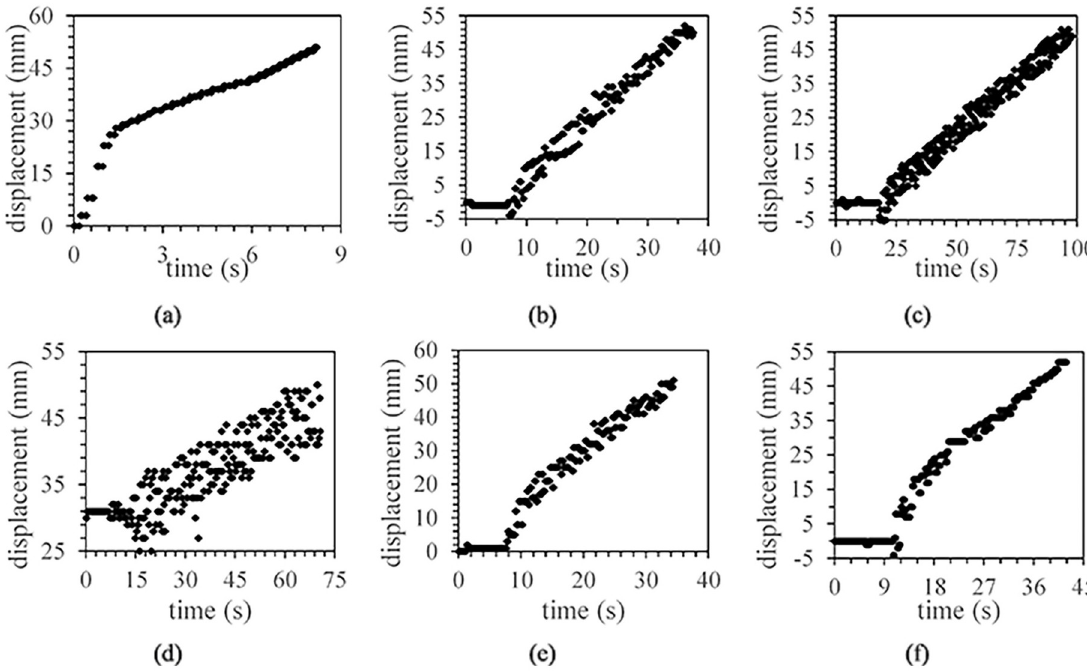
Fig 4. Displacement data distribution characteristics of each concrete block during drilling. (a)No. 1 concrete. (b)No. 2 concrete. (c) No. 3 concrete. (d)No. 4 concrete. (e)No. 5 concrete. (f)No. 6 concrete.